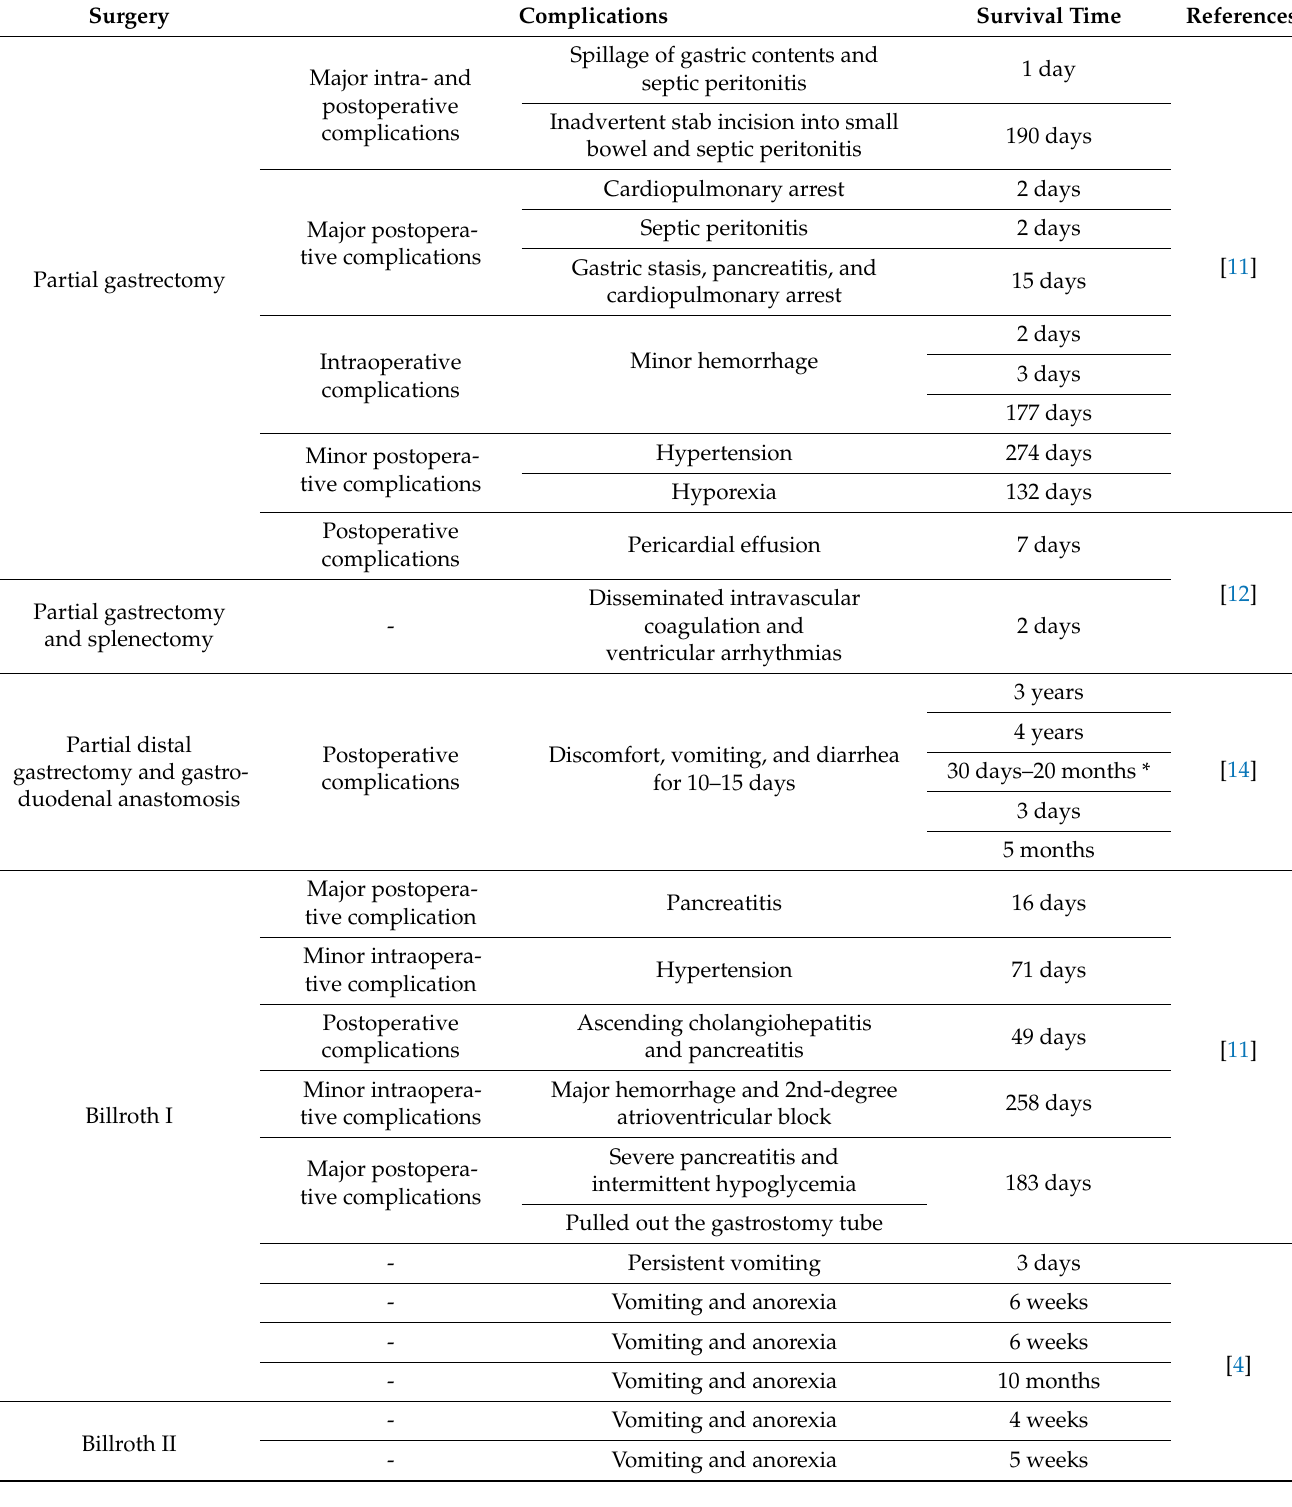
Table 1. Perioperative complications associated with canine gastric carcinoma surgical